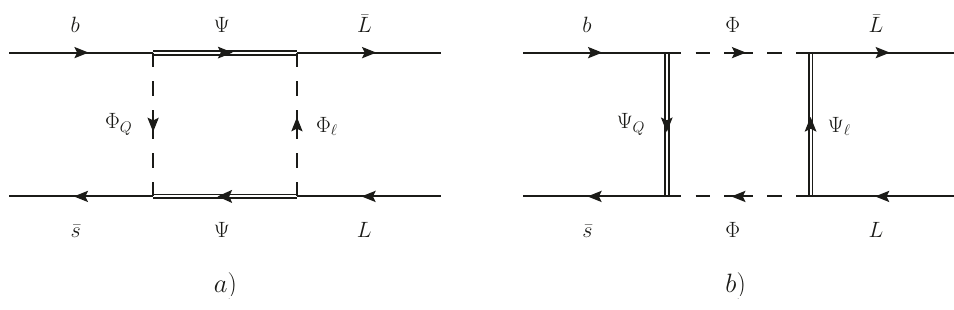
Figure 1 . Box-diagrams contributing to b ! s‘ + ‘ (cid:0) and b ! s(cid:23) (cid:22) (cid:23) in case a ) and b